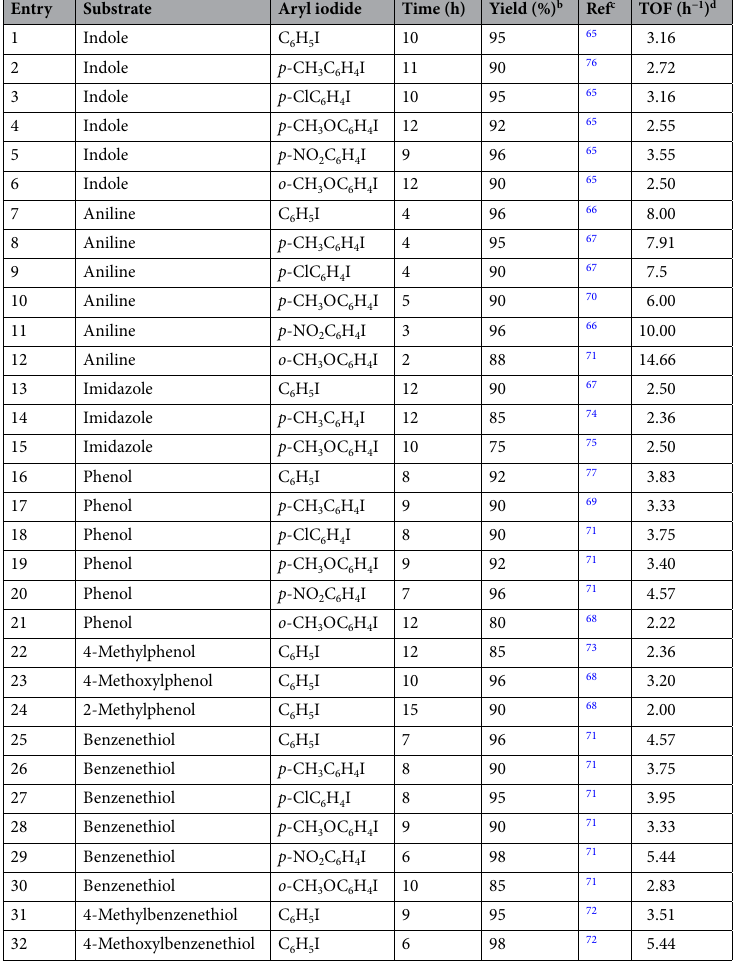
Table 2. CuO/ S. lavandulifolia NPs -catalyzed coupling of amines, phenols, and thiols with aryl iodides. Reaction conditions: amines/phenols/thiols (1.0 mmol), iodobenzene (1.1 mmol), catalyst (3 mol%), KOH (1.5 mmol), stirring in DMSO (3.0 mL) in N 2 at 100 °C; b Isolated yield; c Known product; d TOF, turnover frequencies (TOF = (Yield/Time)/Amount of catalyst (mol).